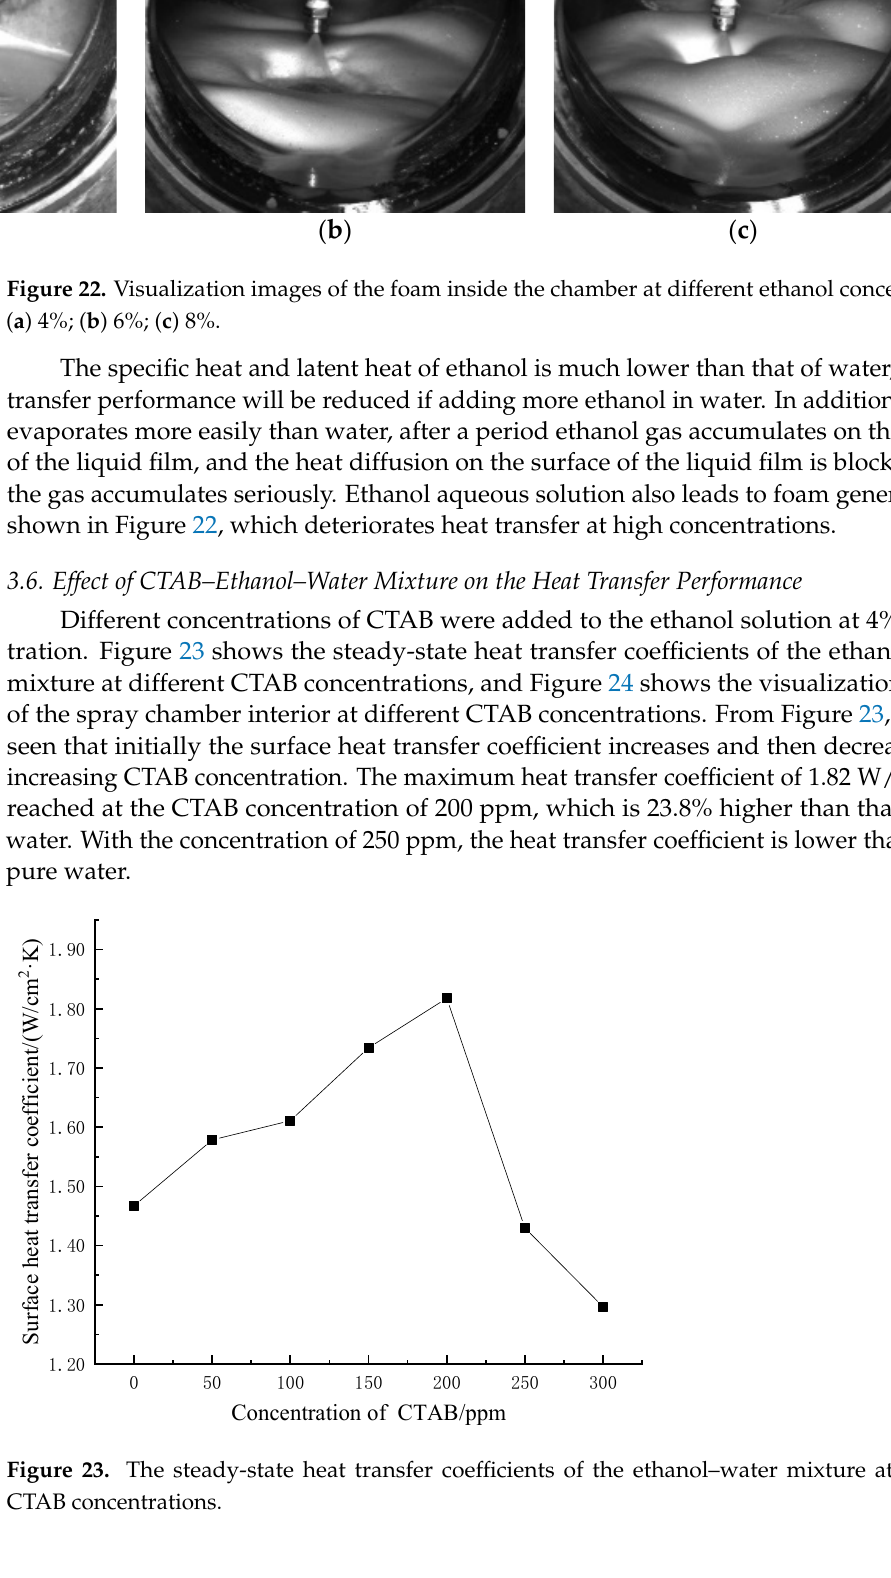
( c ) Figure 24. Visualization images of the foam inside the chamber of the ethanol–water mixture at different CTAB concentrations: ( a ) 20 ppm; ( b ) 40 ppm; ( c ) 60 ppm. 3.7. Dimensionless Criterion Correlation Equations Based on Experimental Parameters The Nusselt number, Reynolds number and Planter number are the most commonly used dimensionless numbers to characterize convective heat transfer. In this experiment, since the nozzle height and spray coverage were changed during the process, the intro- duction of the size coefficient h/D was considered, and the two different correlation forms were: